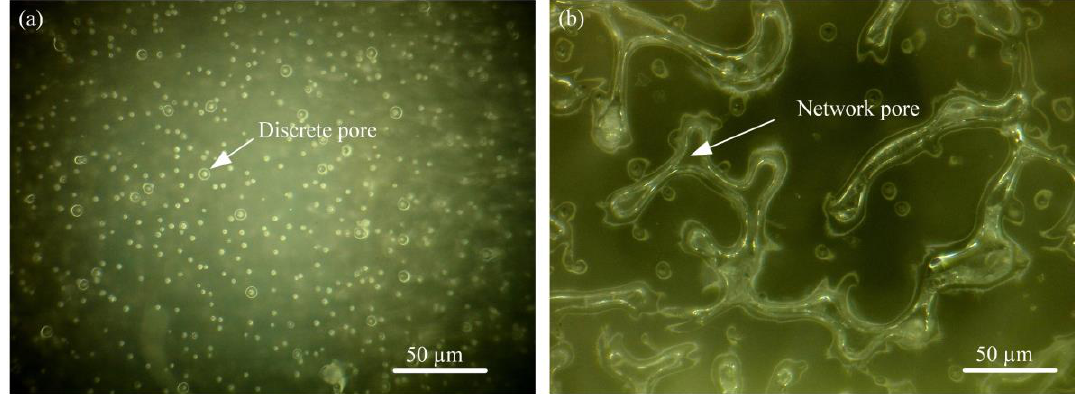
Figure 4. OM images of the bubbles ’ morphologies: ( a ) type I bubbles and ( b ) type II bubbles.